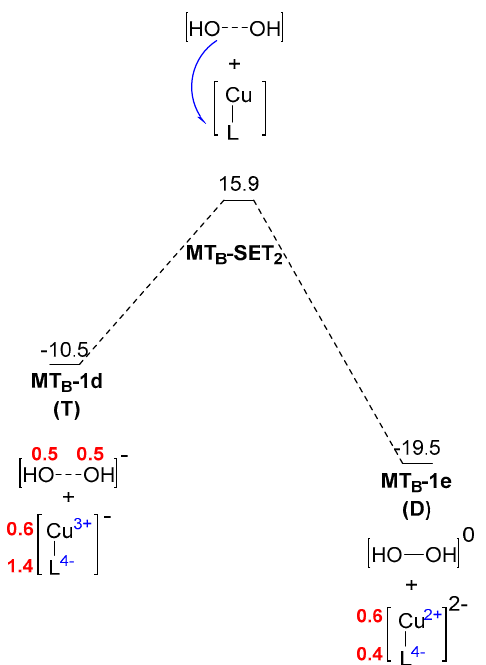
Figure 4. Free energy profile for the second SET applying Marcus theory. Energies in kcal/mol. Red numbers correspond to the spin population.